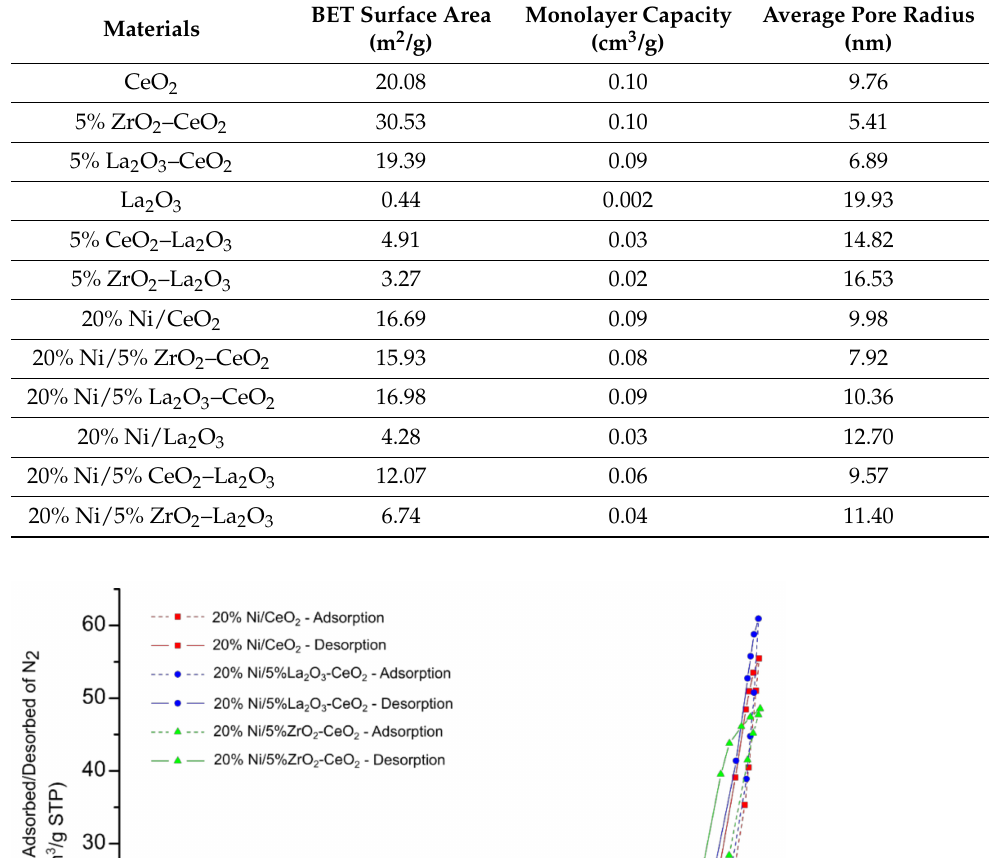
Table 1. The specific surface area, monolayer capacity and average pore size for monometallic supported nickel catalysts calcined in an air atmosphere at 400 ◦ C for 4 h.